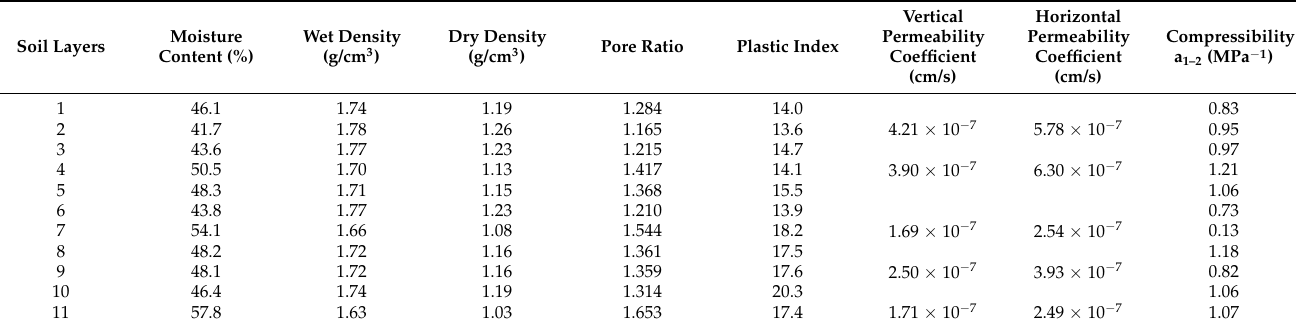
Figure 12. Mesh schematic of the numerical model. Table 2. Soil physical properties of numerical